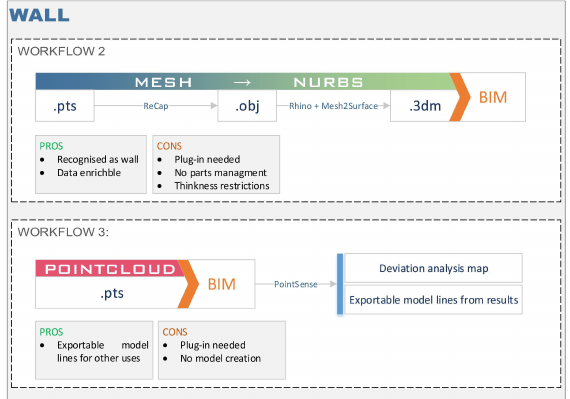
Figure 13. Synthetic diagram that shows the results of workflow